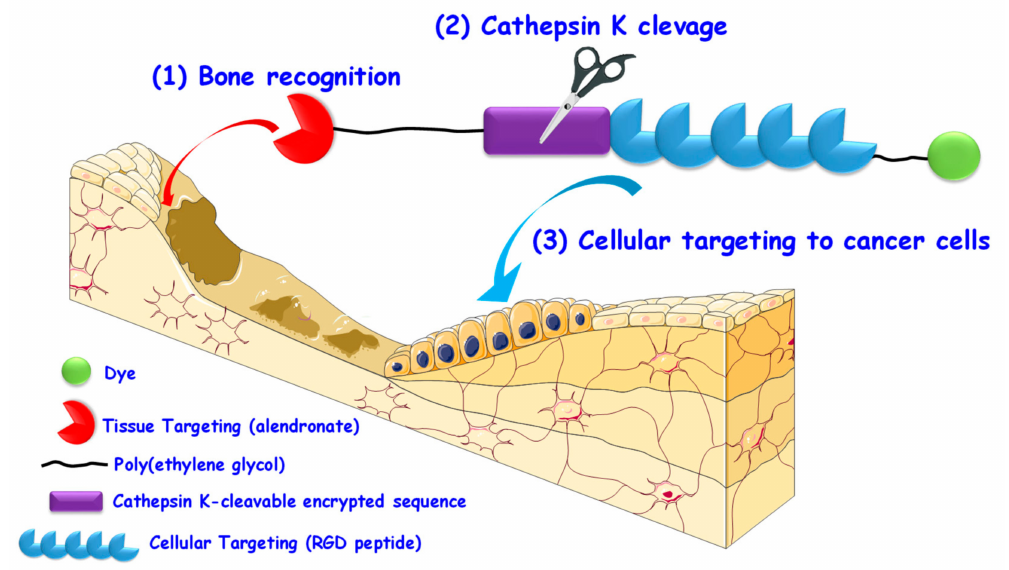
Figure 4. Encrypted approach for the sequential targeting of bone cancer tissue and cancer